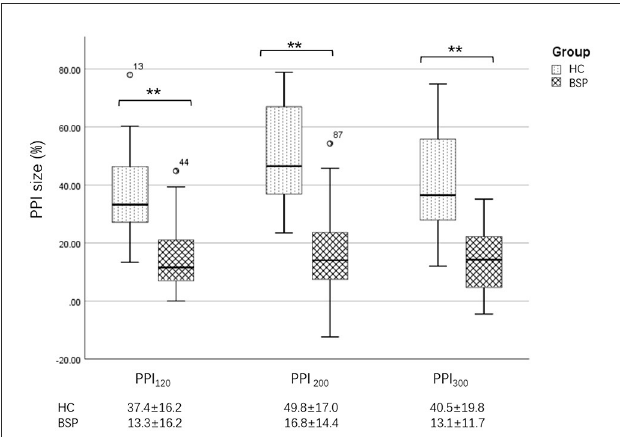
FIGURE3 Differences in PPI size between the HC and BSP groups. PPI 120 , prepulse inhibition at ISIs of 120ms; PPI 200 , prepulse inhibition at ISIs of 200ms; PPI 300 , prepulse inhibition at ISIs of 300ms. All comparisons were performed using the independent-sample t -test. ** p < 0.01.